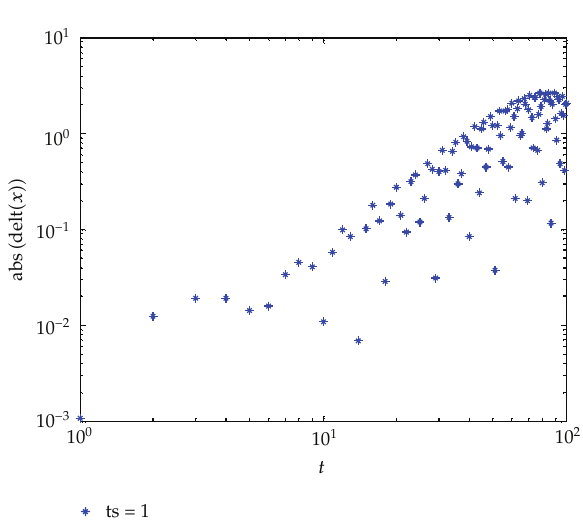
Figure 3: The log-log plot of the error between the ECM and RK.